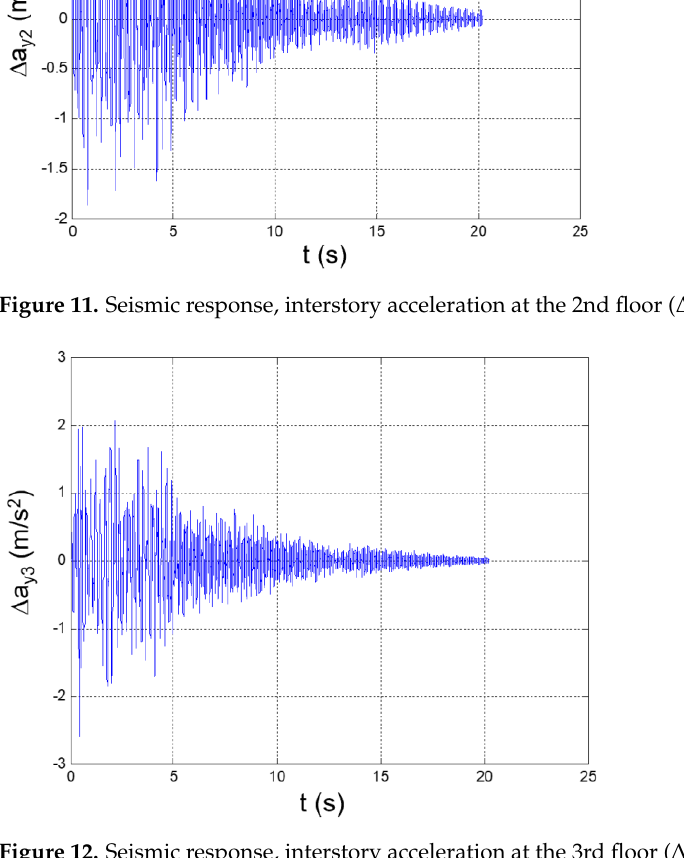
Figure 12. Seismic response, interstory acceleration at the 3rd floor ( Δ 𝑎 y3 = 𝑎 y3 − 𝑎 y2 ).